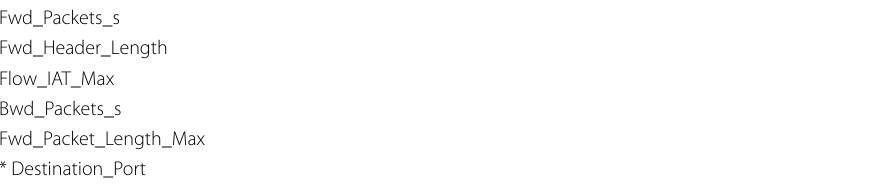
Table 11 Features appearing in at least 6 out of 7 rankings of CSE-CIC-IDS2018, referred